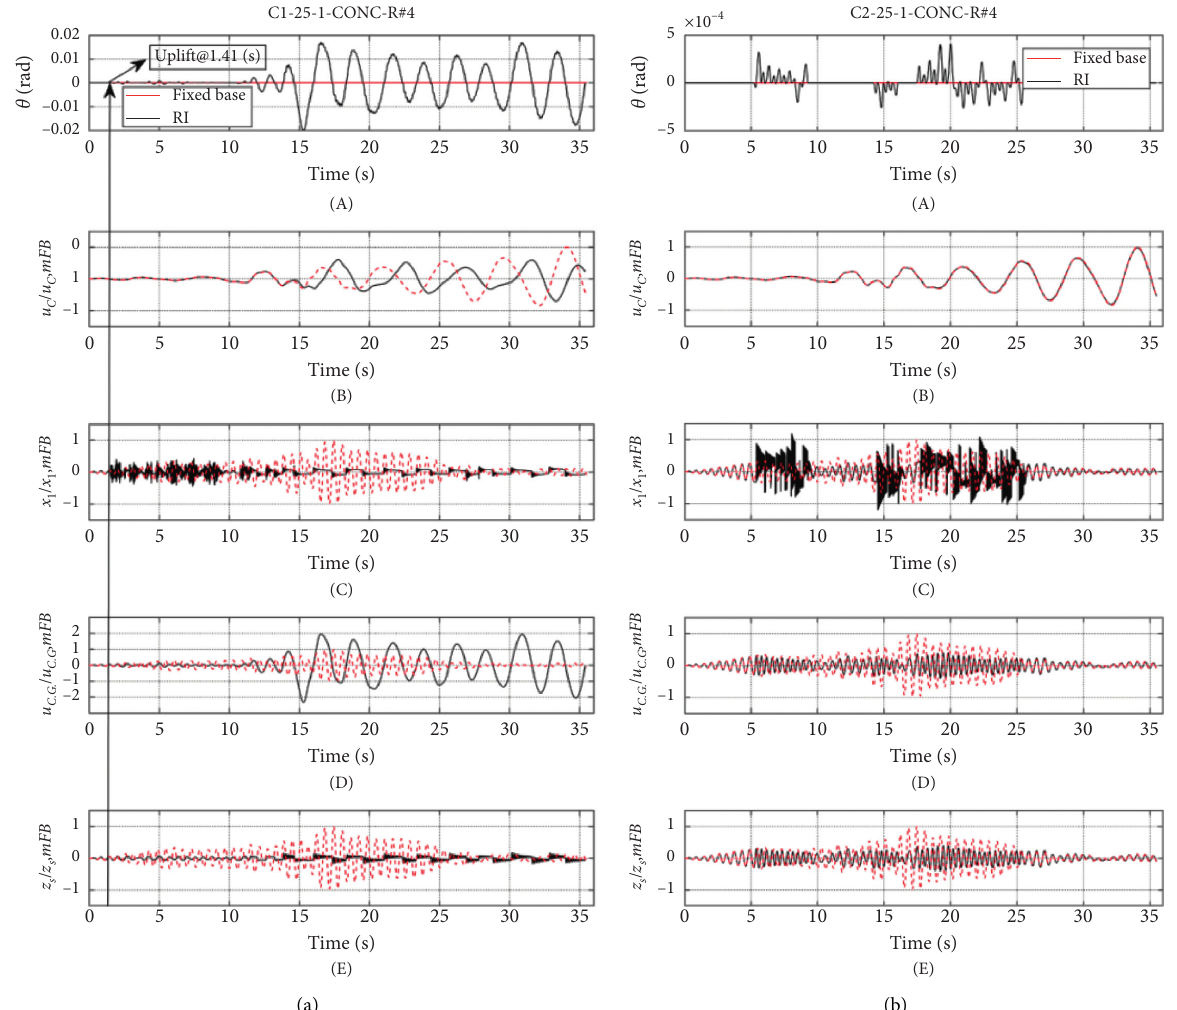
Figure 13: Normalized time histories of (A) rocking, (B) convective, (C) flexibility, (D) impulsive, and (E) shaft top end deformation responses for the structure with C1 (a) and with C2